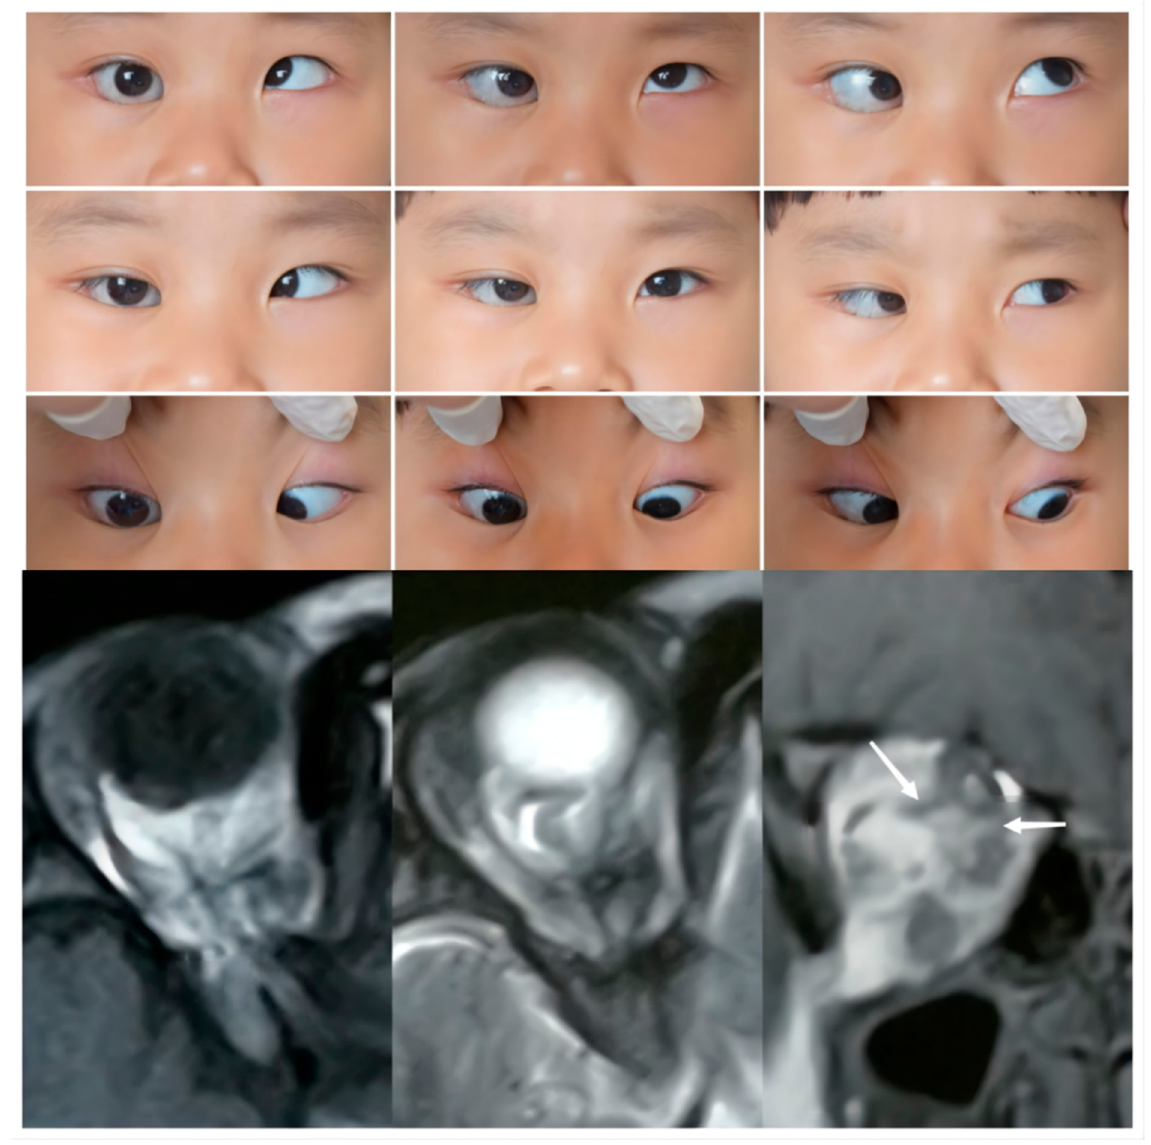
Figure 2. Upper Panel : Nine gaze photographs of Case 2 showing a 30 PD esotropia and -4 limitation in the abduction of the right eye. The right eye showed eyelid entropion, with palpebral aperture 2 mm larger than that of the left eye. Bottom Panel : T1 and T2 axial and a T2 coronal MRI of Case 2. Anomalies in EOM bands extended from the apex of orbit and connected with multiple recti. The right optic nerve was maldeveloped and its path was unclear.